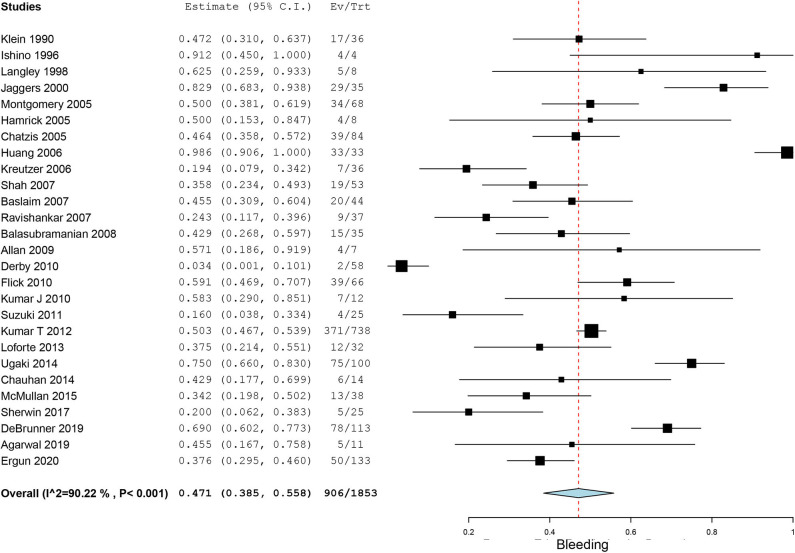
Forest plots assessing incidence of bleeding in patients on extracorporeal membrane oxygenation.